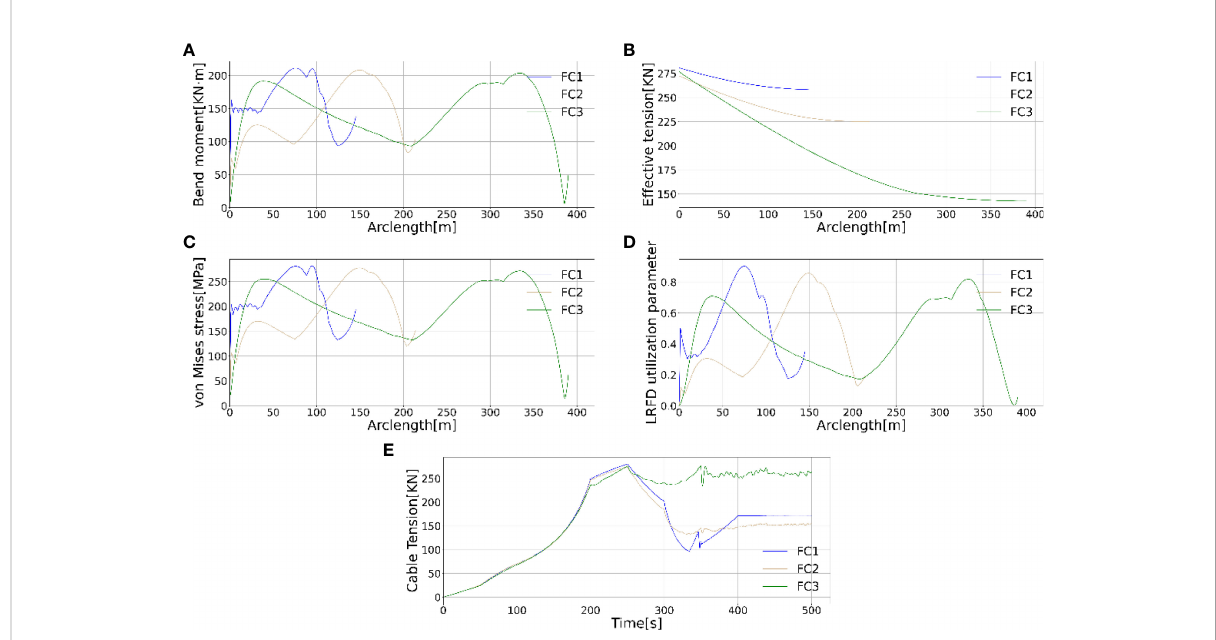
FIGURE 7 The bending moment (A) , effective tension (B) , Von Mises stress (C) , LRFD utilization (D) and cable tension (E) time history in water depths 130m, 200m and 360m, respectively during the connecting process.